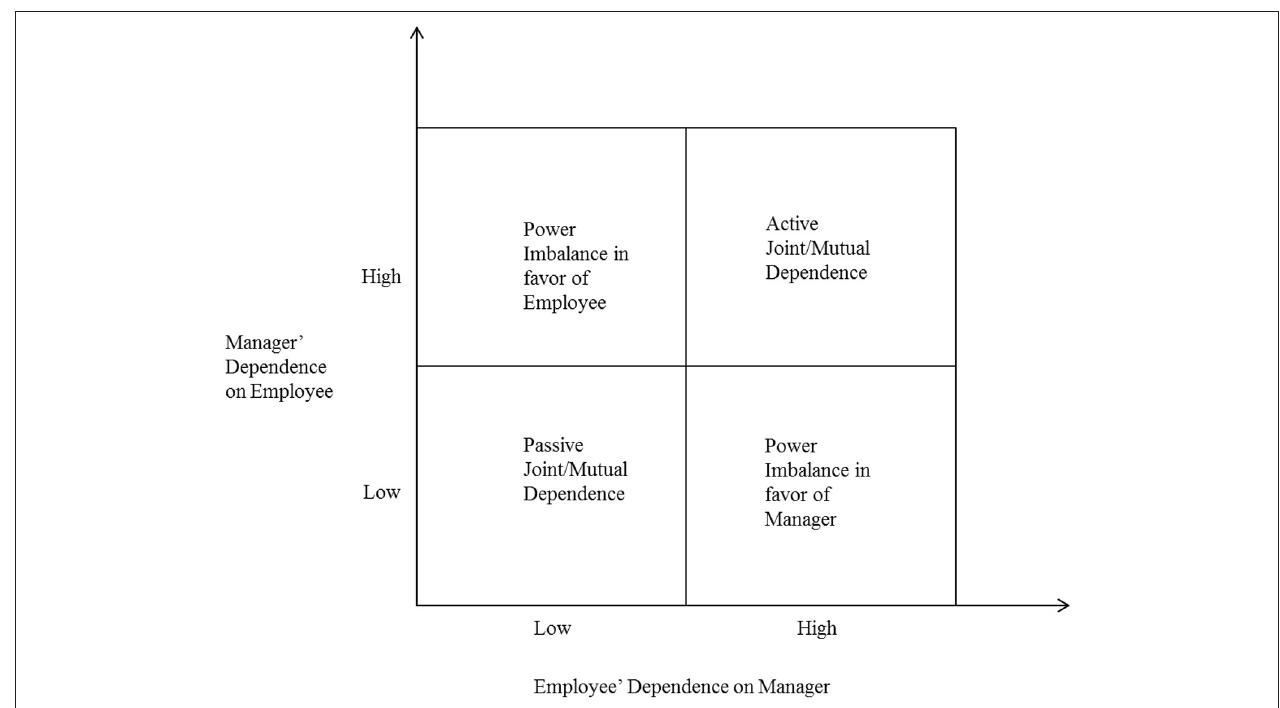
FIGURE 2 | Dependence relationships between an employee and a